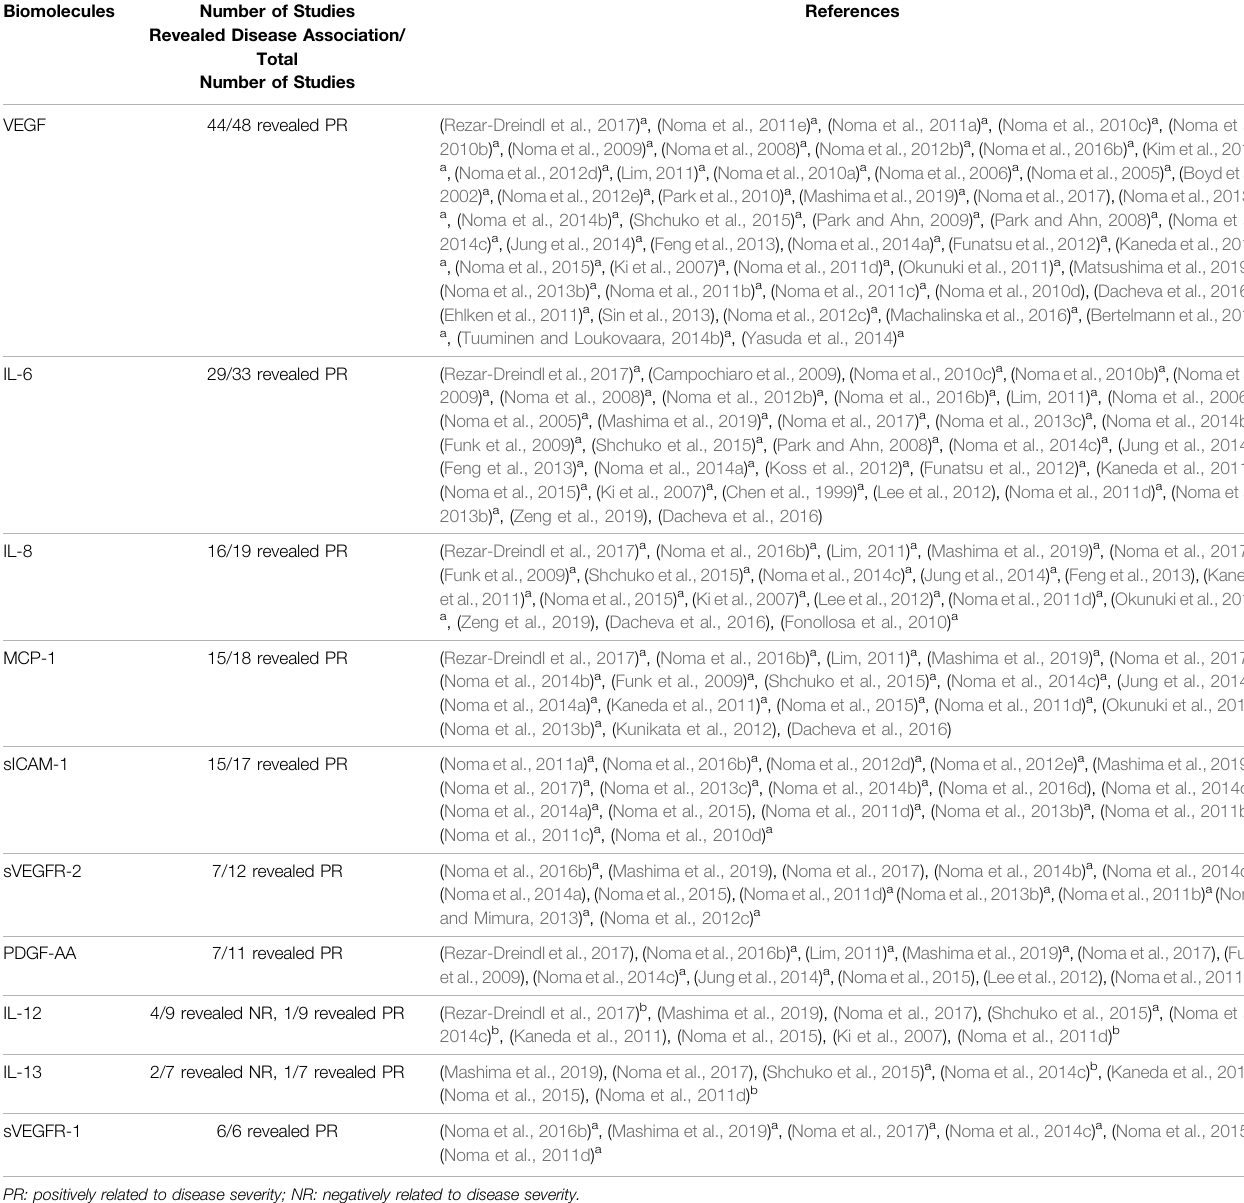
TABLE 1 | The most studied intraocular biomolecules associated with disease severity in